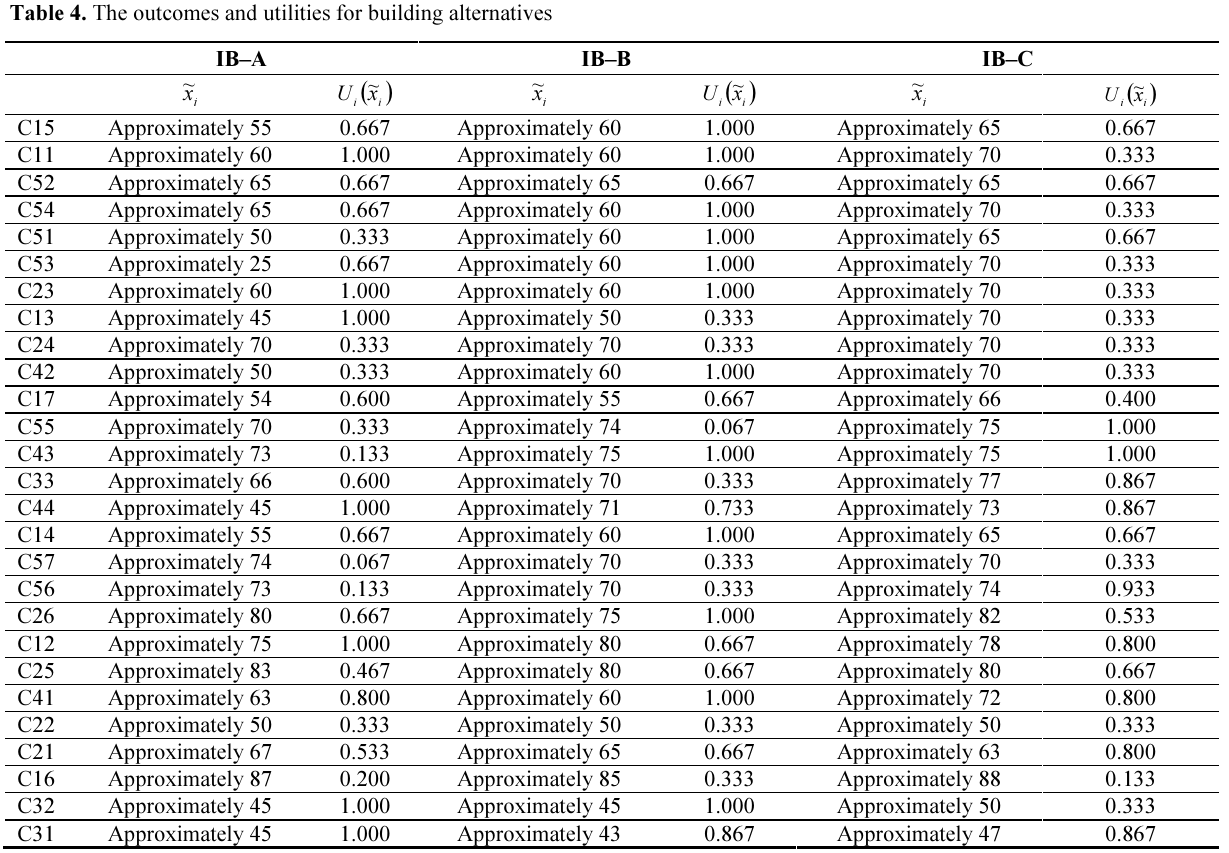
Table 4. The outcomes and utilities for building